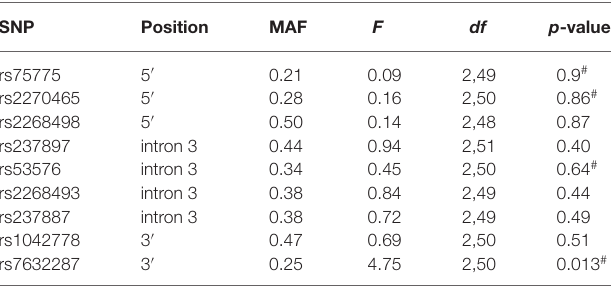
TABLE 1 | Association analysis results for the oxytocin receptor ( OXTR ) polymorphisms and face recognition (dprime).